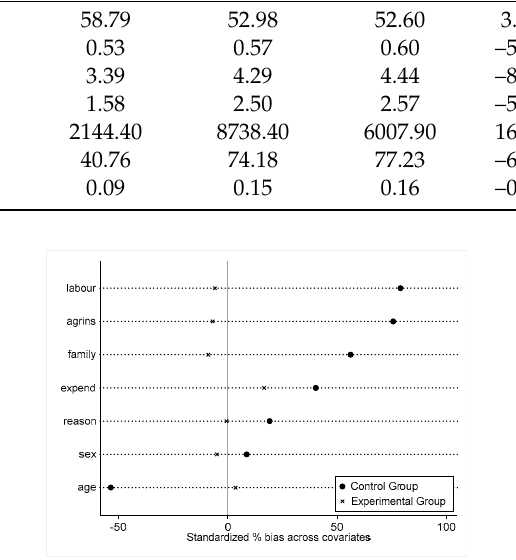
Table 4. Balance test of k-nearest neighbor matching.